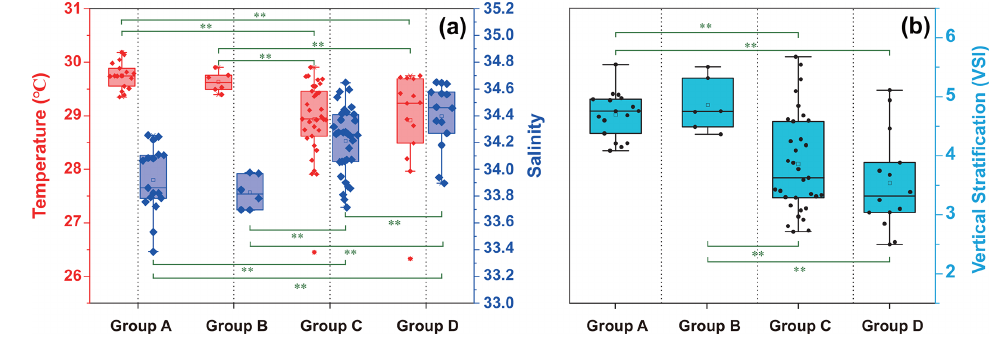
Figure 9. Surface temperature and salinity (a) , and vertical stratification index (b) of the four groups. Table 2. Average ( ± standard deviation) values for nutrients (µmolL − 1 ), temperature ( ◦ C), and salinity for each phytoplankton community group identified by the cluster analysis in the WPO.